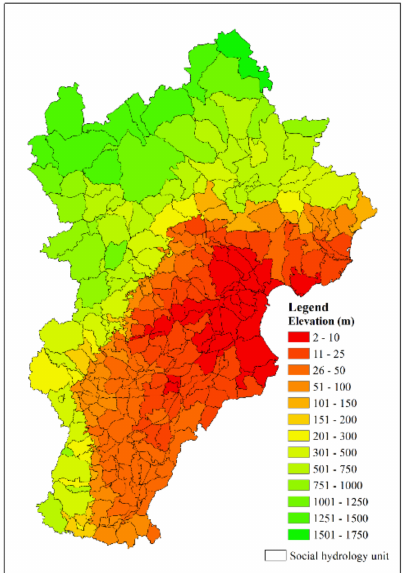
Figure 9. The elevation of river buffer zone in each socio-hydrological unit.